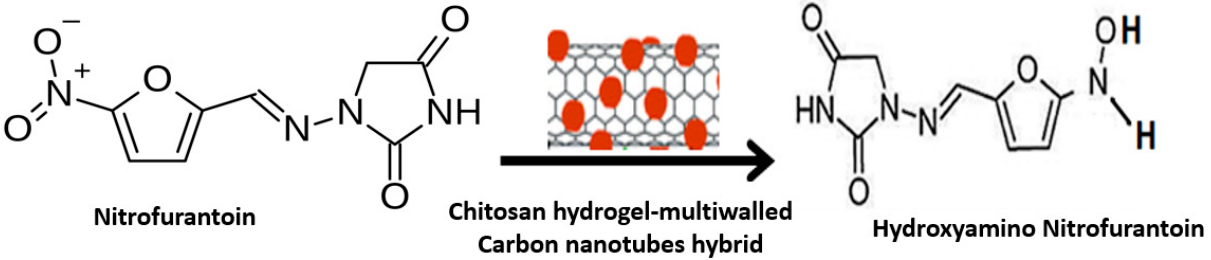
Figure 17. Chitosan hydrogel-multiwalled carbon nanotubes hybrid assisted. Electrochemical reduction of nitrofurantoin to hydroxyamino nitrofurantoin.